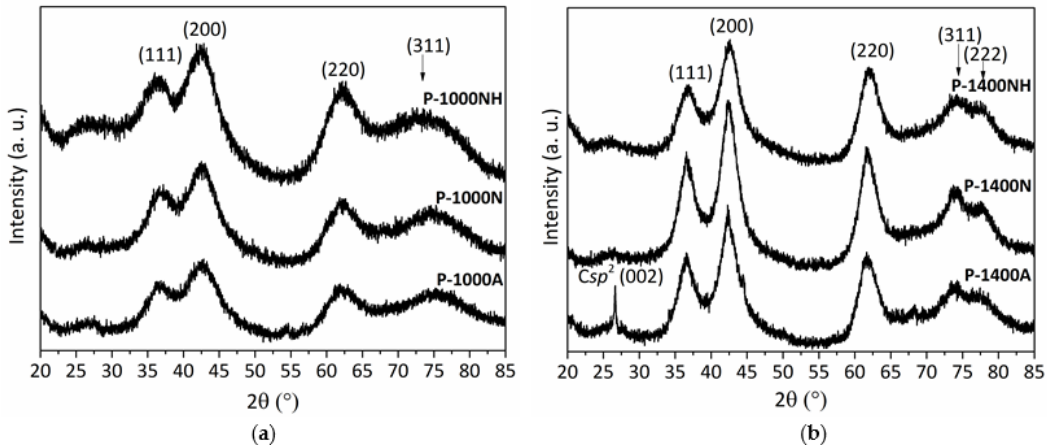
Figure 12. XRD patterns of P-1000NH , P-1000N and P-1000A ( a ) and P-1400NH, P-1400N and the P-1400A ( b ).